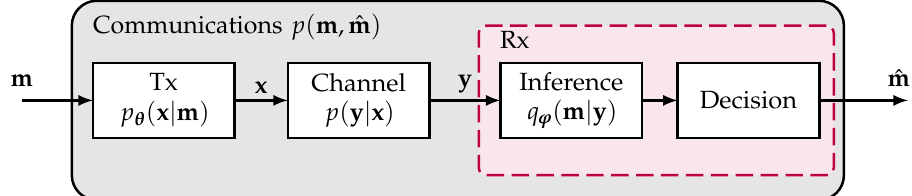
Figure 7. Typical communications design, but here adapted for transmission of the semantic or message variable m . For exploration, the communication system is a black box and only needs to be abstracted for the purpose of integration as a factor node with joint pdf p ( m , ˆ m )